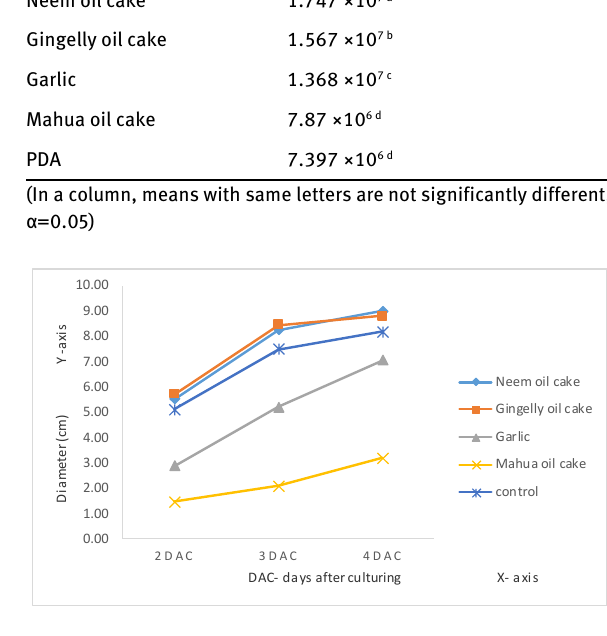
Mycelial growth of T. viride